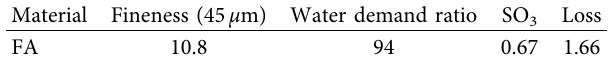
Table 4: Basic physical and mechanical properties of FA (in